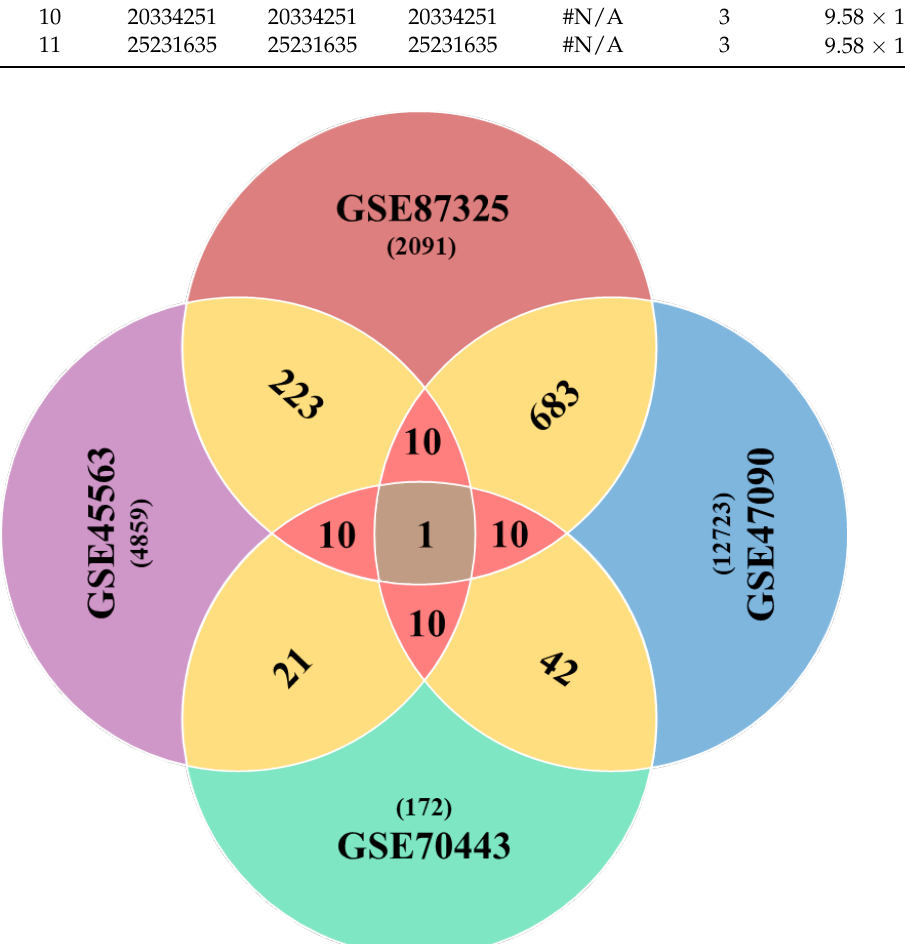
Figure 2 . Venn diagram elaborating shared number of genes across the combinations of microarray datasets. Sharing of DE genes between two datasets are shown in gold color, while sharp pink color represents three combination outcomes, in terms of sharing the number of DE genes.